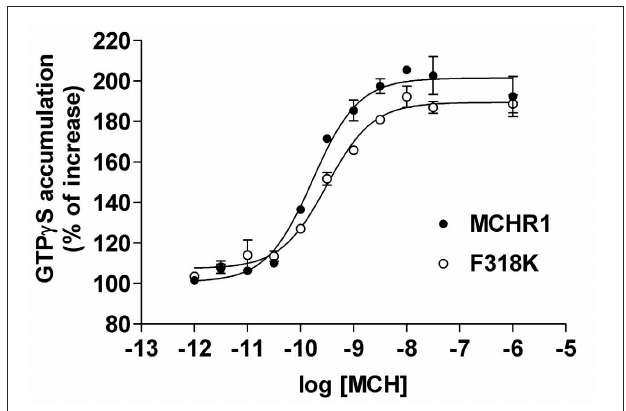
FIGURE 6 | MCH-induced [ 35 S]GTP γ S binding to Flag-MCHR1 and F318K. HEK293T cells were transfected with Flag-MCHR1 or F318K. After 48h, the cells were harvested and the membrane fractions recovered. Membrane proteins (10 μ g) were subsequently incubated with 0.2nM [ 35 S]GTP γ S and 0.001–1000nM MCH in GTP γ S binding buffer for 30min at 30 ◦ C. The amounts of radioactivity bound to the membrane preparations are shown for Flag-MCHR1 (filled circles) and F318K (open circles). Results shown are representative of three-independentexperiments.